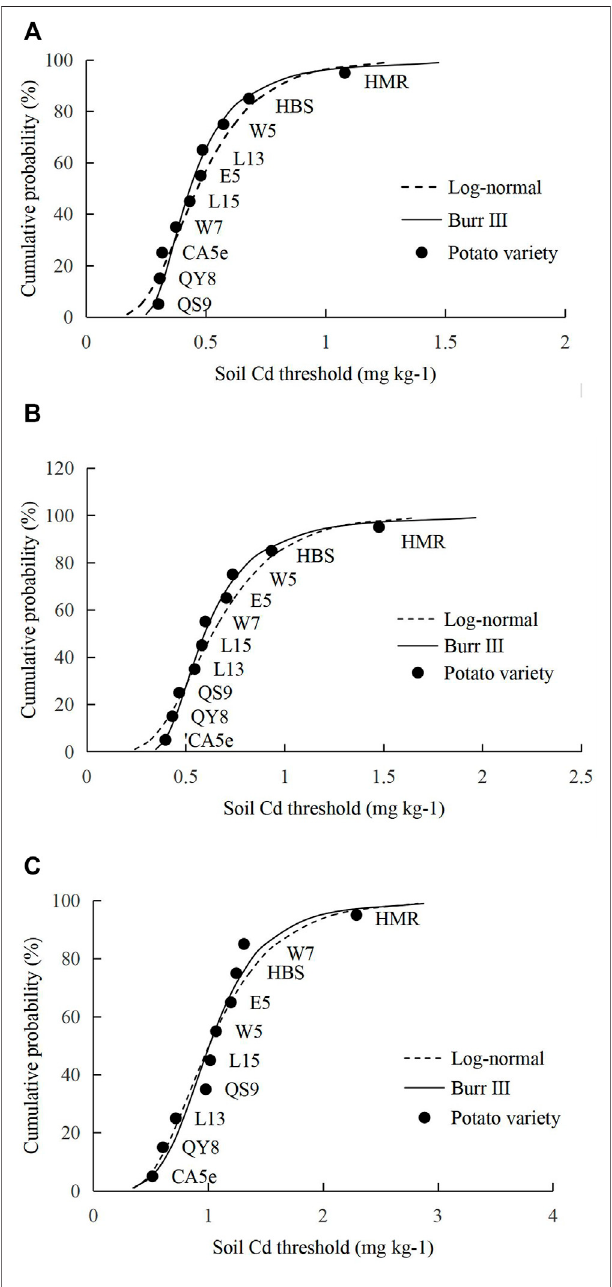
FIGURE 3 | SSD curves of different potato varieties in Weining soil. (A) . BAF ck , (B) . BAF total , (C) . BAF add